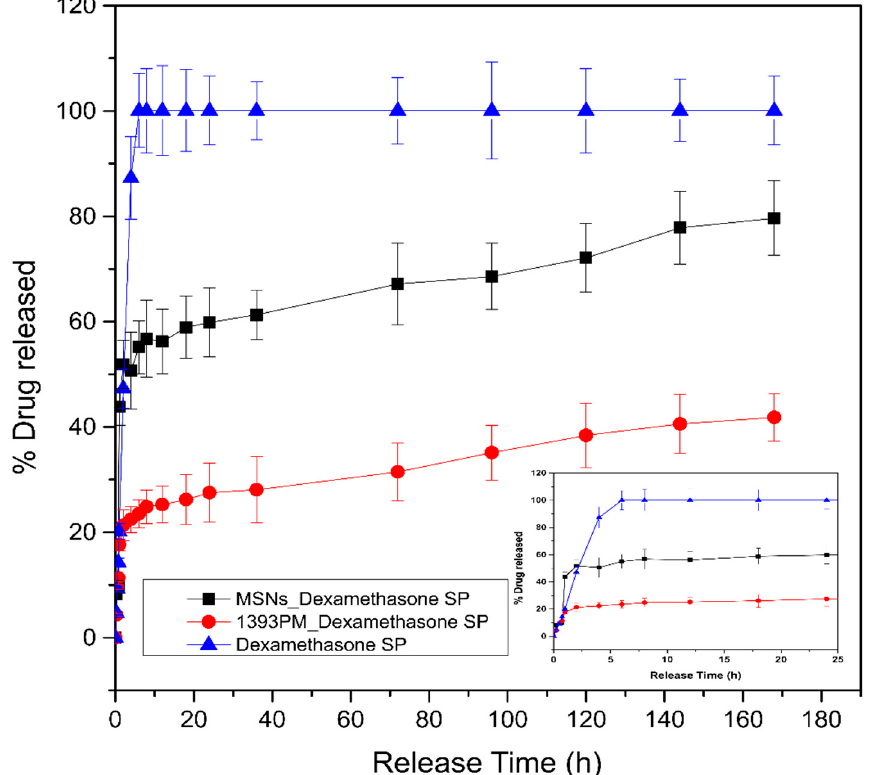
Figure 12. In vitro release study of DexSP from the mesoporous silica nanoparticles. The inset presents the release in the first 20 h.